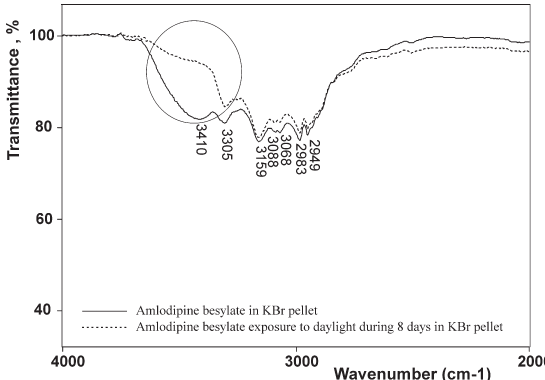
Figure 6a. FTIR spectrum of amlodipine besylate without and with irradiation with daylight during 8 days (range 2000 - 4000 cm -1 )